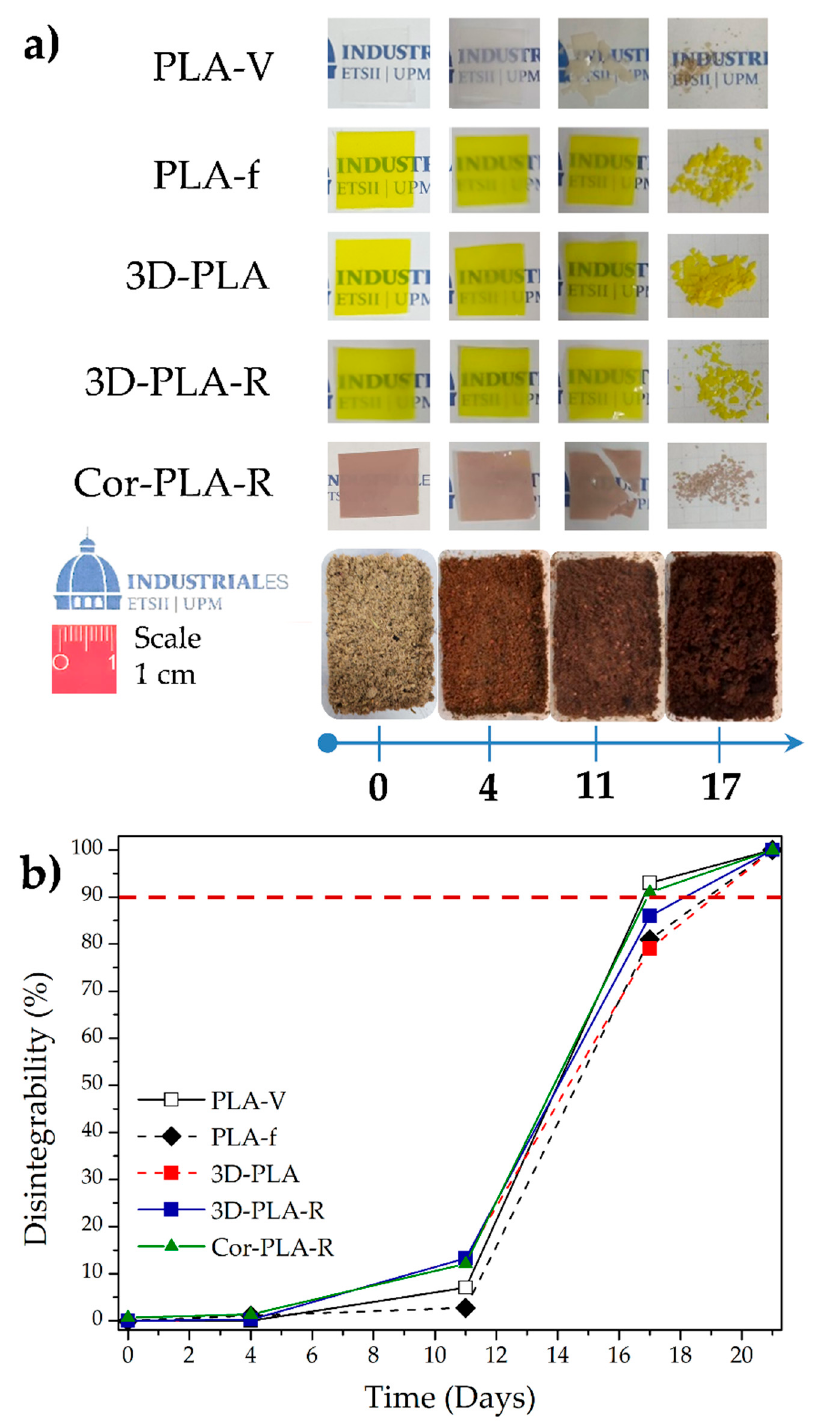
Figure 11. ( a ) Visual appearance of films samples before and after exposition at compost condi ‐ tions, ( b ) films disintegration degree under composting conditions as a function of time and compost evolution during the composting test.